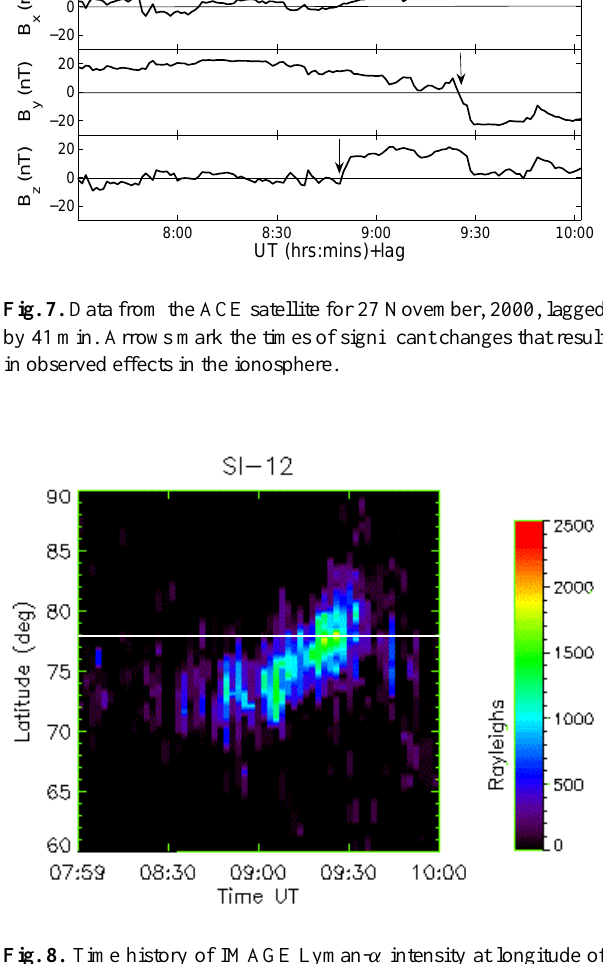
Fig. 8. Time history of IMAGE Lyman- α intensity at longitude of Longyearbyen. The horizontal line marks the latitude of Longyear-